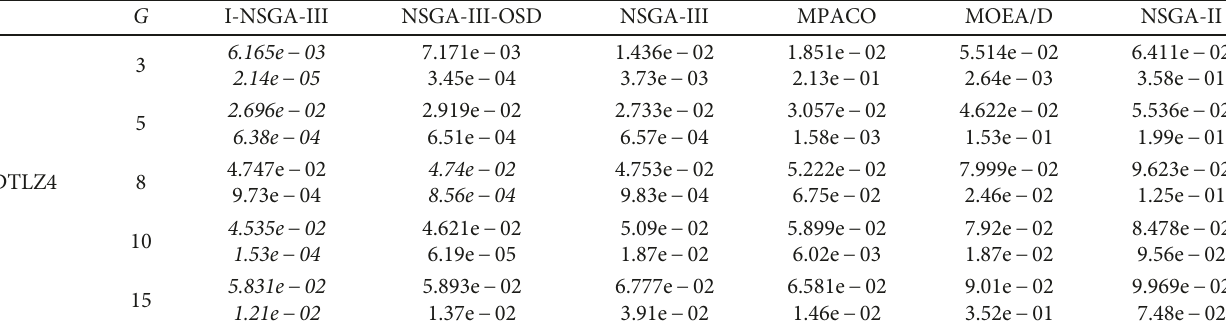
Table 12: Median and standard deviation of the IGD values achieved by each algorithm on DTLZ4 (the best medians are in italic font).